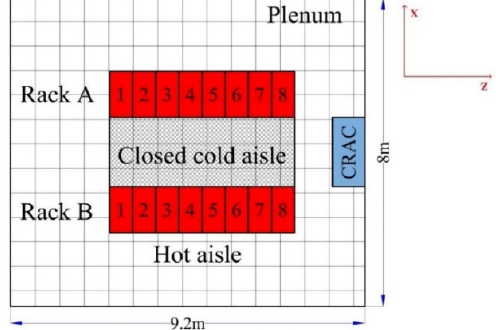
Figure 1. The layout of the base computer room.